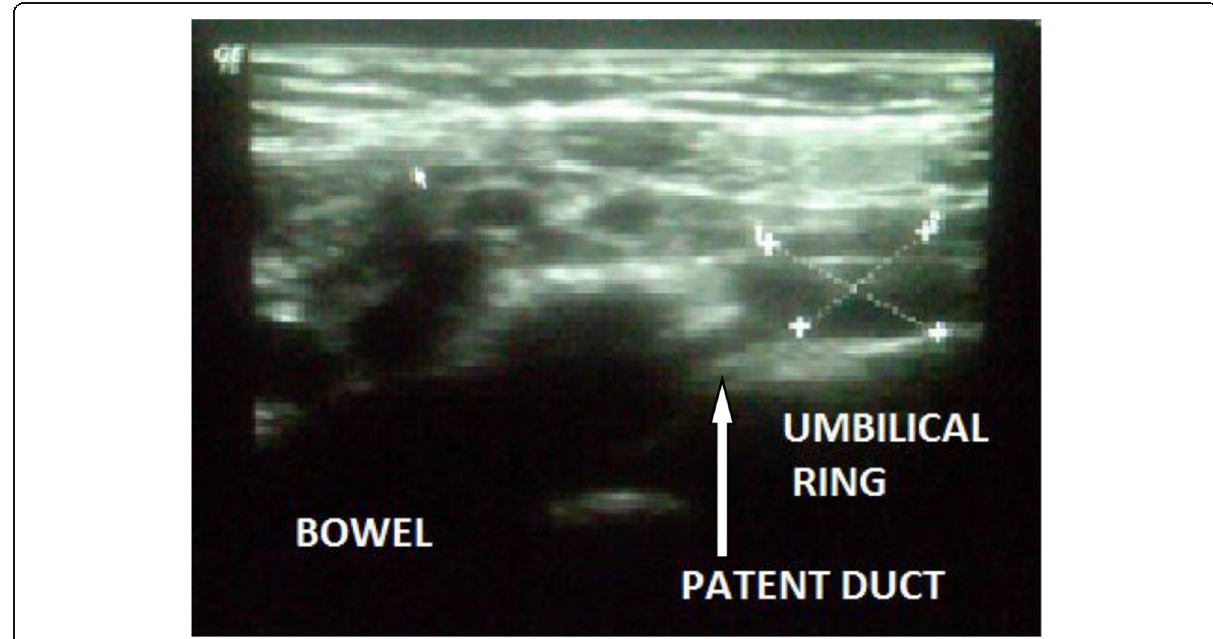
Fig. 1 Sonographic appearance of vitello-intestinal